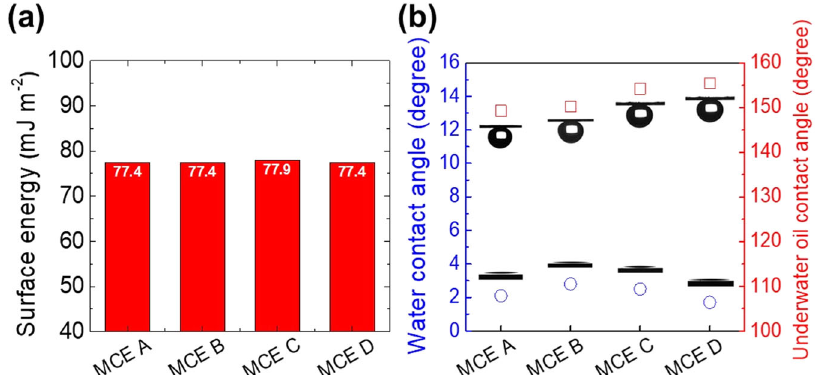
Fig. 5 Superhydrophilicity and superoleophobicity. a Surface free energy; b water contact angle in air (blue) and oil contact angle under water (red) of four coated MCE